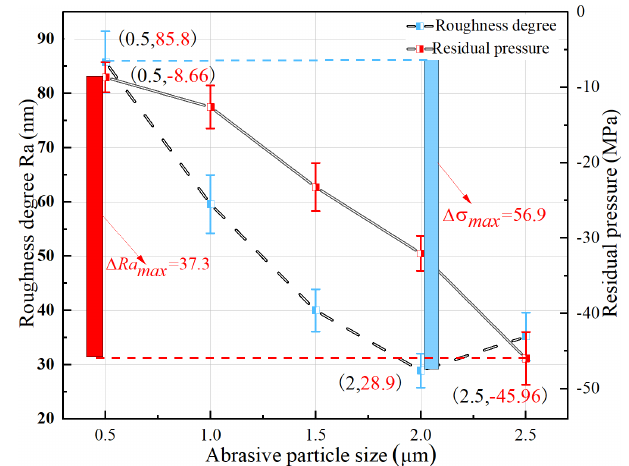
Figure 11. Relationship of particle size with surface roughness and residual stress.